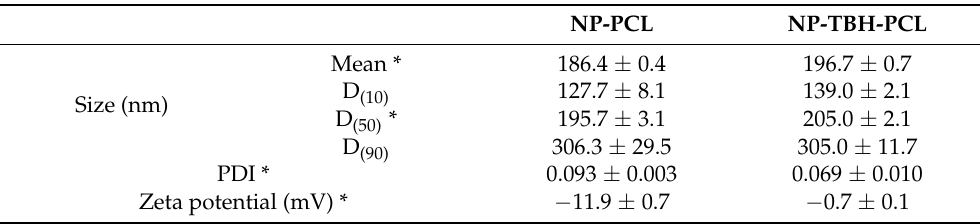
Table 2. The size distribution and Zeta potential of nanoparticles without and with terbinafine using the dynamic light-scattering (DLS) procedure employing Zetasizer.